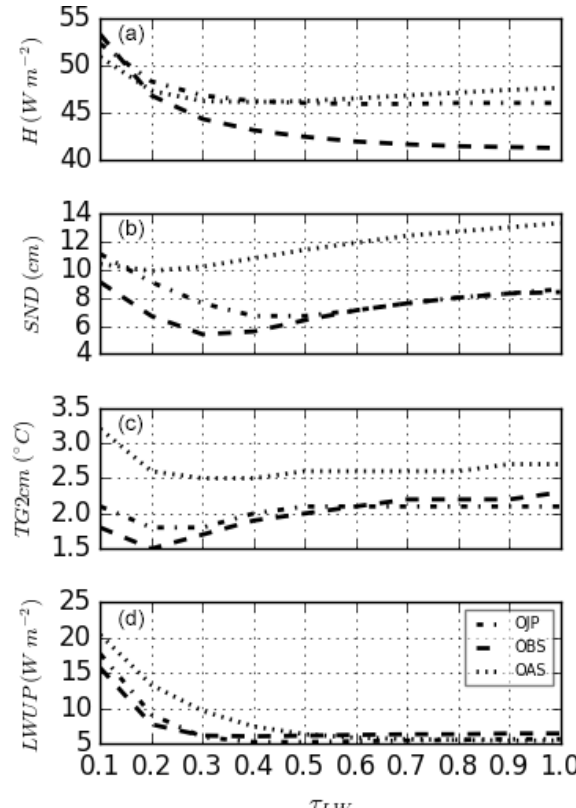
Figure 11. RMSE calculated for different values of τ LW for each site during the snow period and for the sensible heat flux (a) , snow depth (b) , soil temperature at 2cm (c) , and LW ↑ (d) .